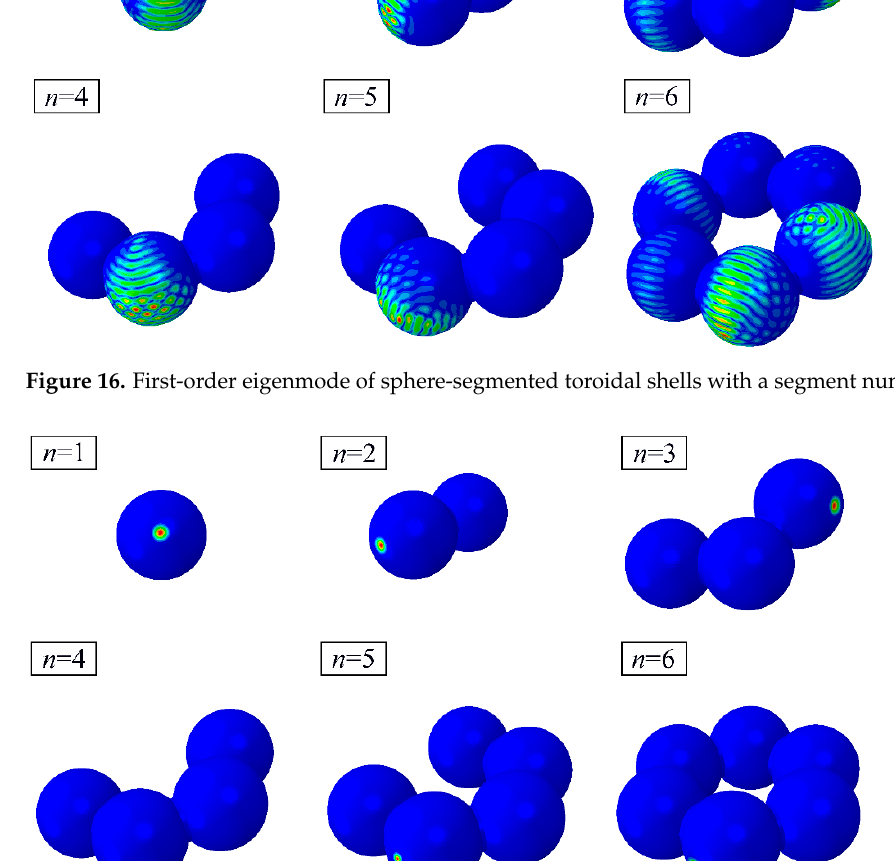
Table 6. First yield load ( P y ) and nonlinear buckling load ( Δ = 0 and 0.1 t ) for sphere-segmented toroidal shells with a segment number ( n ) of 1–6. n = 1